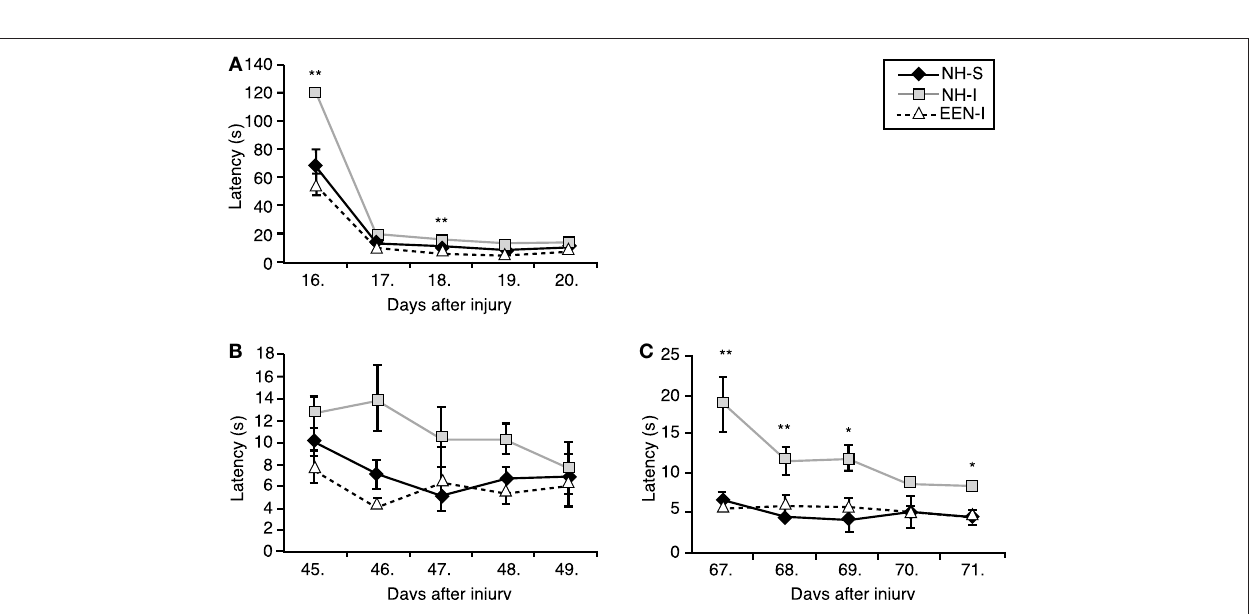
Figure 2 | Anxiety and basic motor function of animals in the various experimental groups. Elevated plus maze was used to measure changes in basic motor function and anxiety levels. Total distance traveled (meter) (A) , duration of time spent (seconds) in open arms (B) and duration of time spent (second) in closed